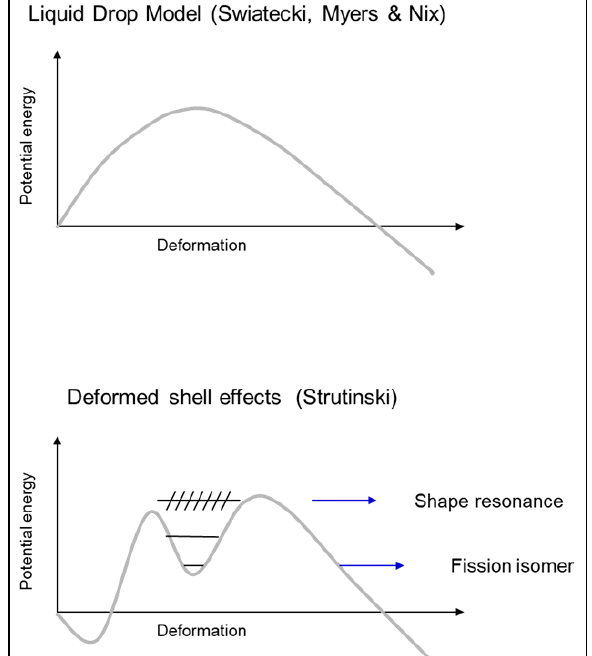
Figure 1. Schematic illustration of how the shell correction to the fission barrier predicted by the Liquid Drop Model (top panel) leads to the double-humped fission barrier (bottom panel), which supports a fission isomer state (the ground state in the second well) and excited  -vibrational states that manifest themselves as resonances in the fission probability.